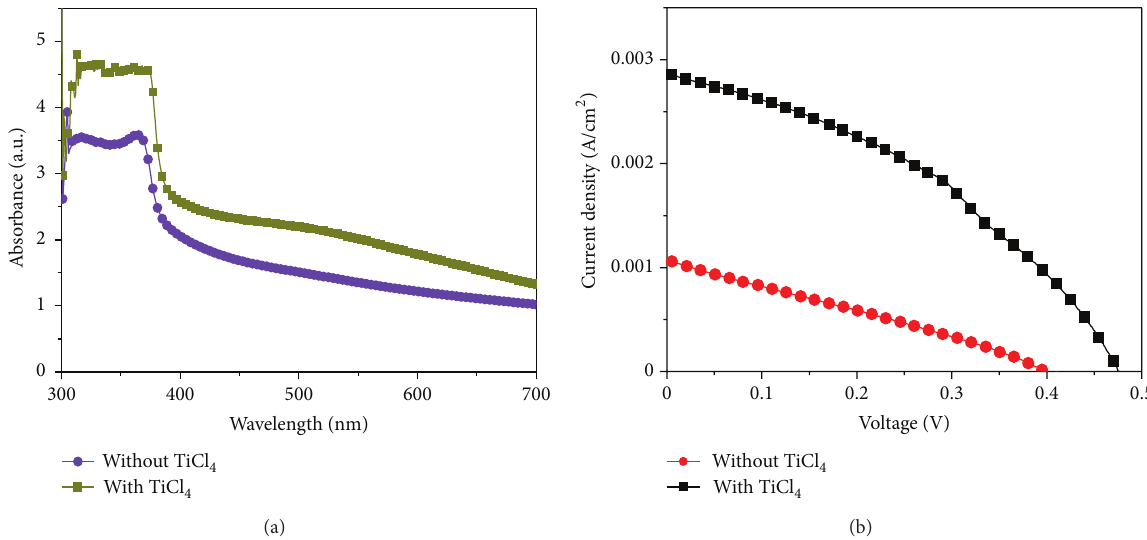
Figure 3: (a) UV-Vis absorption spectra of ZnO films. TiCl 4 pretreatment (dark yellow). Without TiCl 4 pretreatment (blue). (b) J - V curves obtained from DSSCs with TiCl 4 pretreatment (black) and DSSCs without TiCl 4 pretreatment (red).